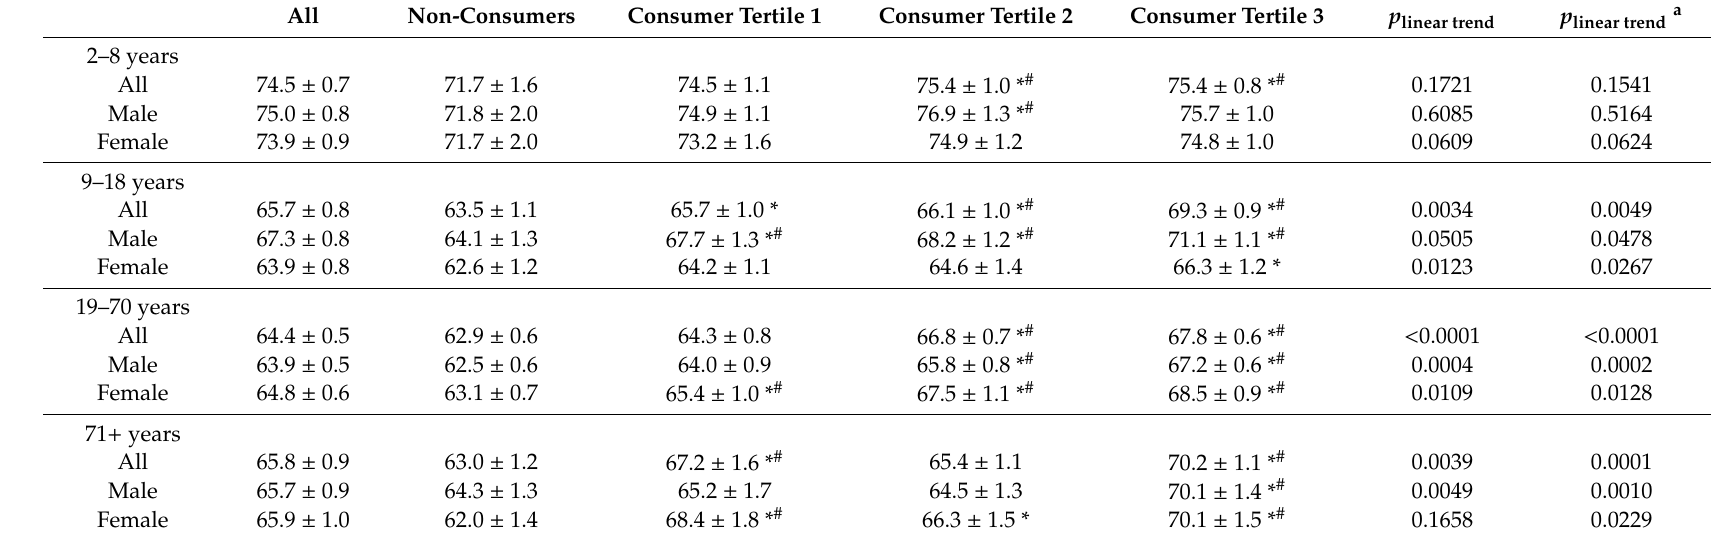
Table 4. Serum Vitamin D (serum 25(OH)D) status (nmol / L) by all milk intake in di ff erent age and gender groups, NHANES